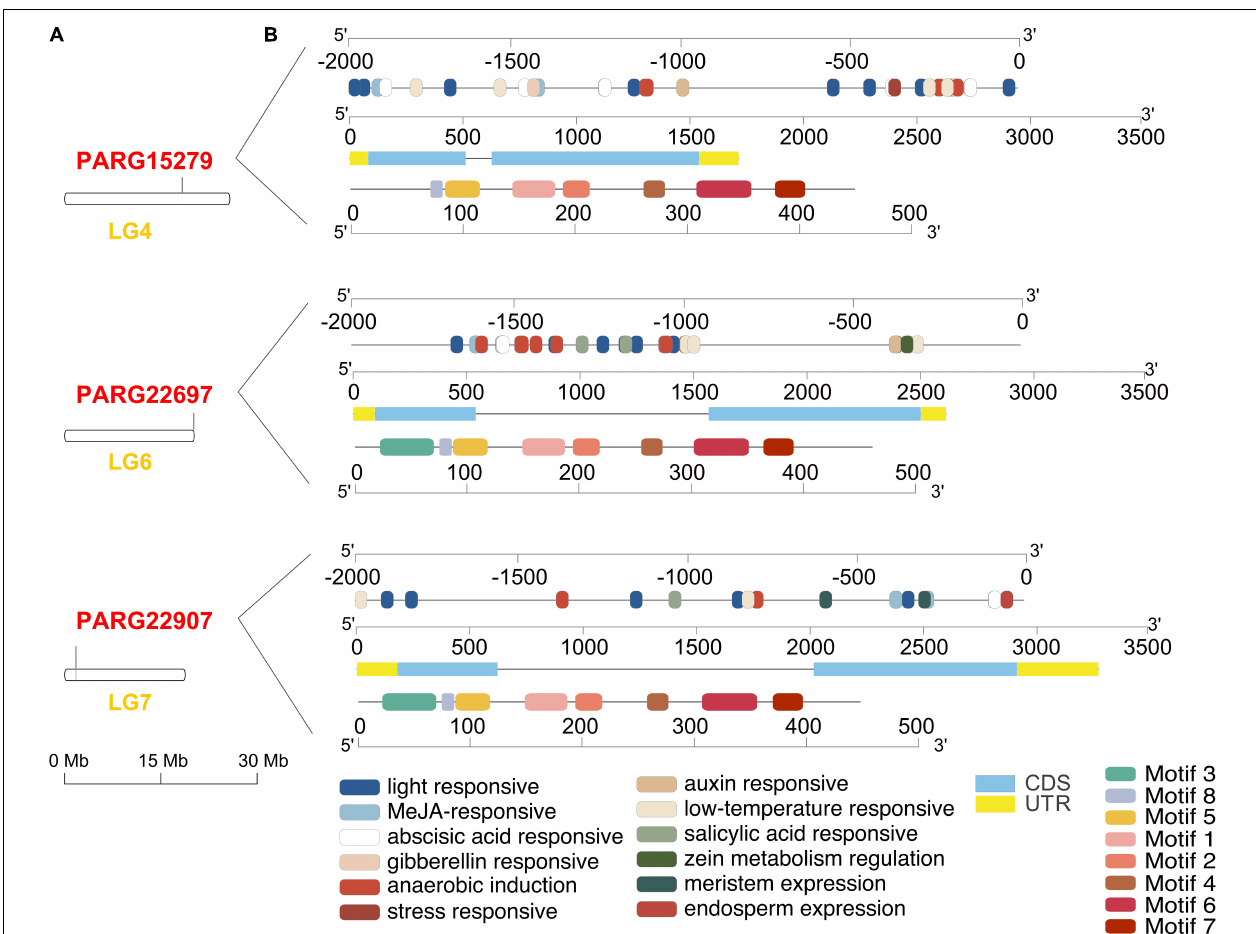
FIGURE 1 | Gene structure of alcohol acyltransferase in apricot. (A) Distribution of three AAT genes on the different linkage group (LG) of the apricot genome. (B) The upper section shows the cis -elements distributed in the promoters of apricot AAT genes, and the rectangles of different colors represent cis -elements with different functions. The middle section shows the untranslated 5 (cid:48) - and 3 (cid:48) -regions (UTR), pink boxes indicate coding sequence length (CDS), and black lines denote introns. The lower section provides the motif structure of the AAT genes.